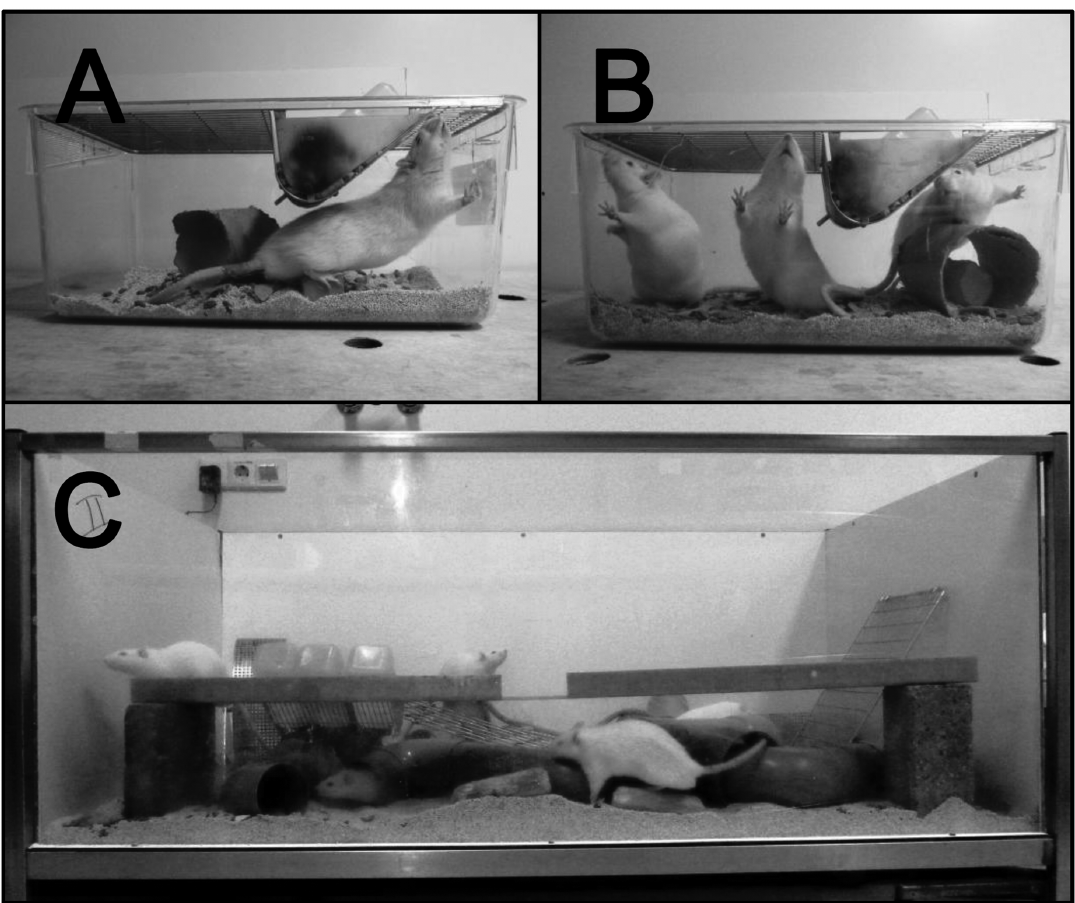
Figure 1. Housing conditions. Pictures of the 3 different housing conditions; solitary housed animals (A), socially housed animals (B), and the animals housed in an enriched environment (C). Of note, the enriched environment picture only represents the object arrangement during one particular week, the constellation and number of items was changed weekly.